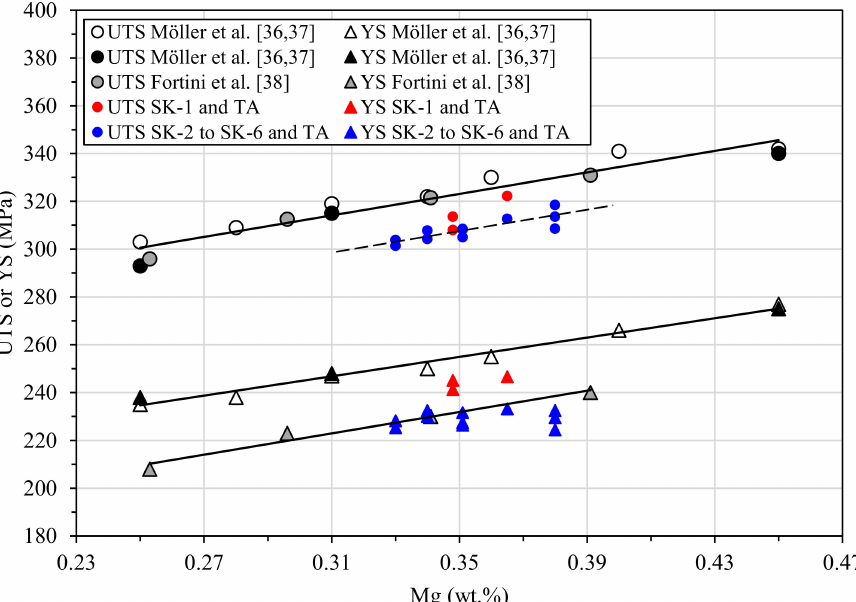
Figure 15. Effect of Mg content on UTS and YS for two series of SSM-A356 alloys from Möller et al. [36,37] and for one series of A356 alloys from Fortini et al. [38]. The different ag- ing treatments were 180 ◦ C and 60 min for alloys from Möller et al. while they were 155 ◦ C and 270 min for alloys from Fortini et al. Red and blue symbols correspond to UTS (circles) and YS (triangles) values obtained from SK-1 to SK-6 and TA castings used in this work which were aged at 165 ◦ C for 280 min and at 155 ◦ C for 360 min, respectively (see the